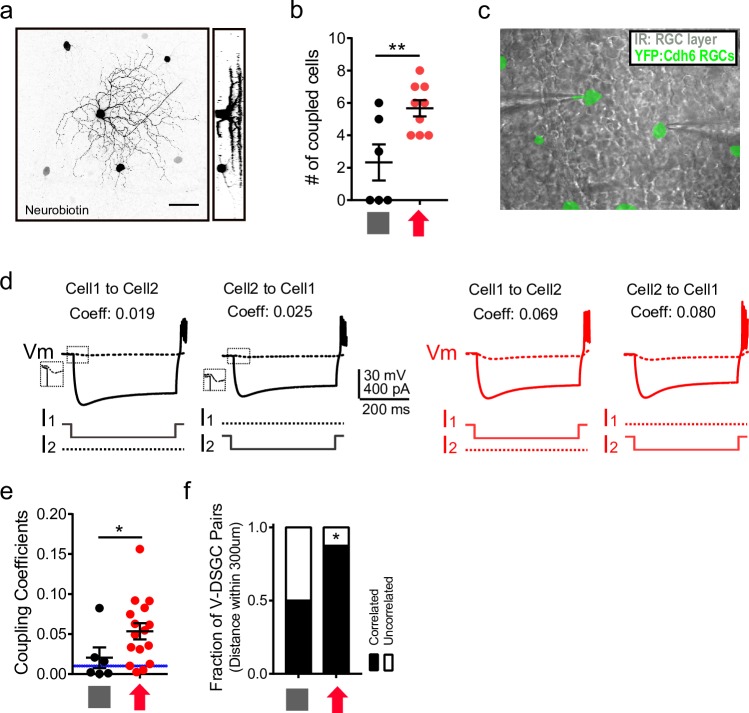
Stronger gap junction connections in V-DSGCs after upward VME.(a) Neurobiotin labeling showing dendritic arborization of a V-DSGC and the somata of neighboring RGCs that are coupled to it. Scale bar, 50 μm. (b) Number of cells coupled to V-DSGCs revealed by neurobiotin labeling of V-DSGCs. Control, 6 V-DSGCs, 2.3 ± 1.1 coupled somata; VME, 9 V-DSGCs, 5.7 ± 0.5 coupled somata. Unpaired t test, p < 0.01. (c) Face-on view of a Cdh6-CreER × Thy1-stop-YFP mouse retina captured during a paired intracellular recording session. Gray, infrared illuminated RGC layer; green, fluorescence of YFP. (d) Electrical coupling between a pair of V-DSGCs each in the control (black) and upward gratings VME (red) groups, as revealed by targeted paired intracellular recording in the Cdh6-CreER × Thy1-stop-YFP retina. In both cases, −200 pA current injection in cell 1 caused hyperpolarization in cell 2 and vice versa. Coupling coefficients are indicated on top. (e) Coupling coefficients for V-DSGC pairs. Control, 6 pairs, mean coupling coefficients 0.02 ± 0.01; VME, 16 pairs, mean coupling coefficients 0.05 ± 0.01. Dashed line shows the threshold for significant coupling. Unpaired t test, p < 0.05. (f) Fraction of electrically coupled V-DSGCs. Control, 50%, 6 pairs; VME, 87.5%, 16 pairs. Chi-squared test, p < 0.05. Data for this figure are in S6 Data. IR, infrared; RGC, retinal ganglion cell; V-DSGC, ventral-preferring direction selective ganglion cell; Vm, membrane potential; VME, visual motion experience; YFP, yellow fluorescent protein.